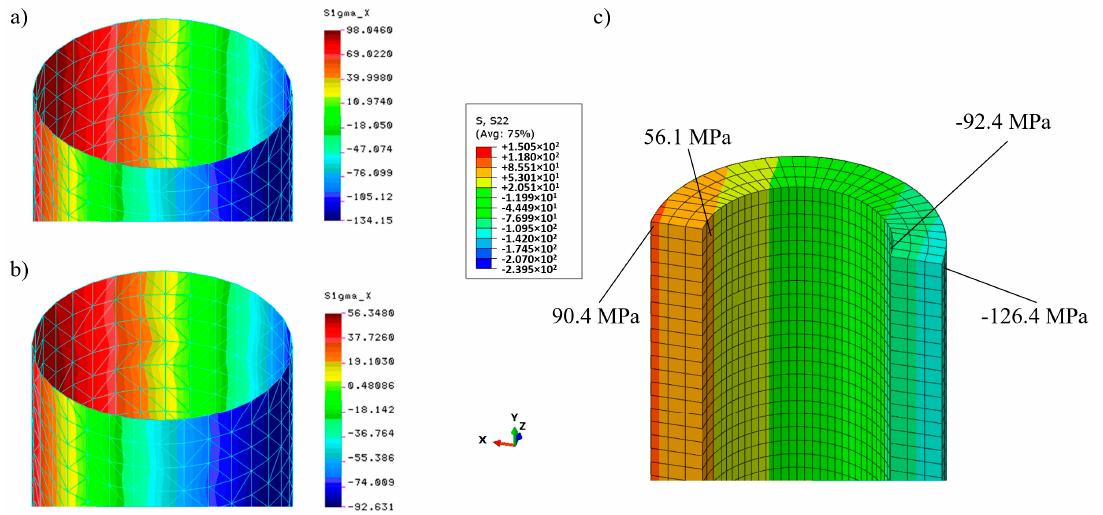
Figure 7. Distribution of the longitudinal stresses at the middle section of the original column (linear analysis) for N = 100 kN: ( a ), ( b ) Outer and inner surfaces (COSMOS/M system); ( c ) distribution along the wall thickness (Simulia Abaqus system).